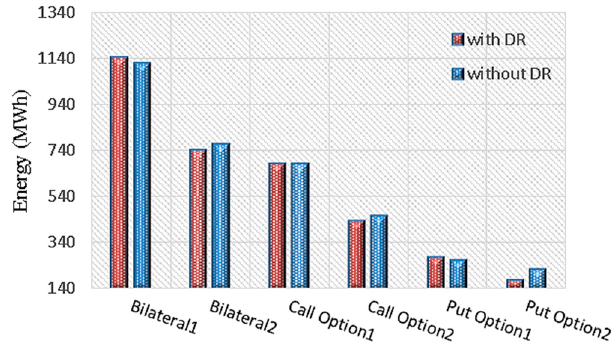
Figure 7. Energy provided through different forward contracts in the fourth scheme.